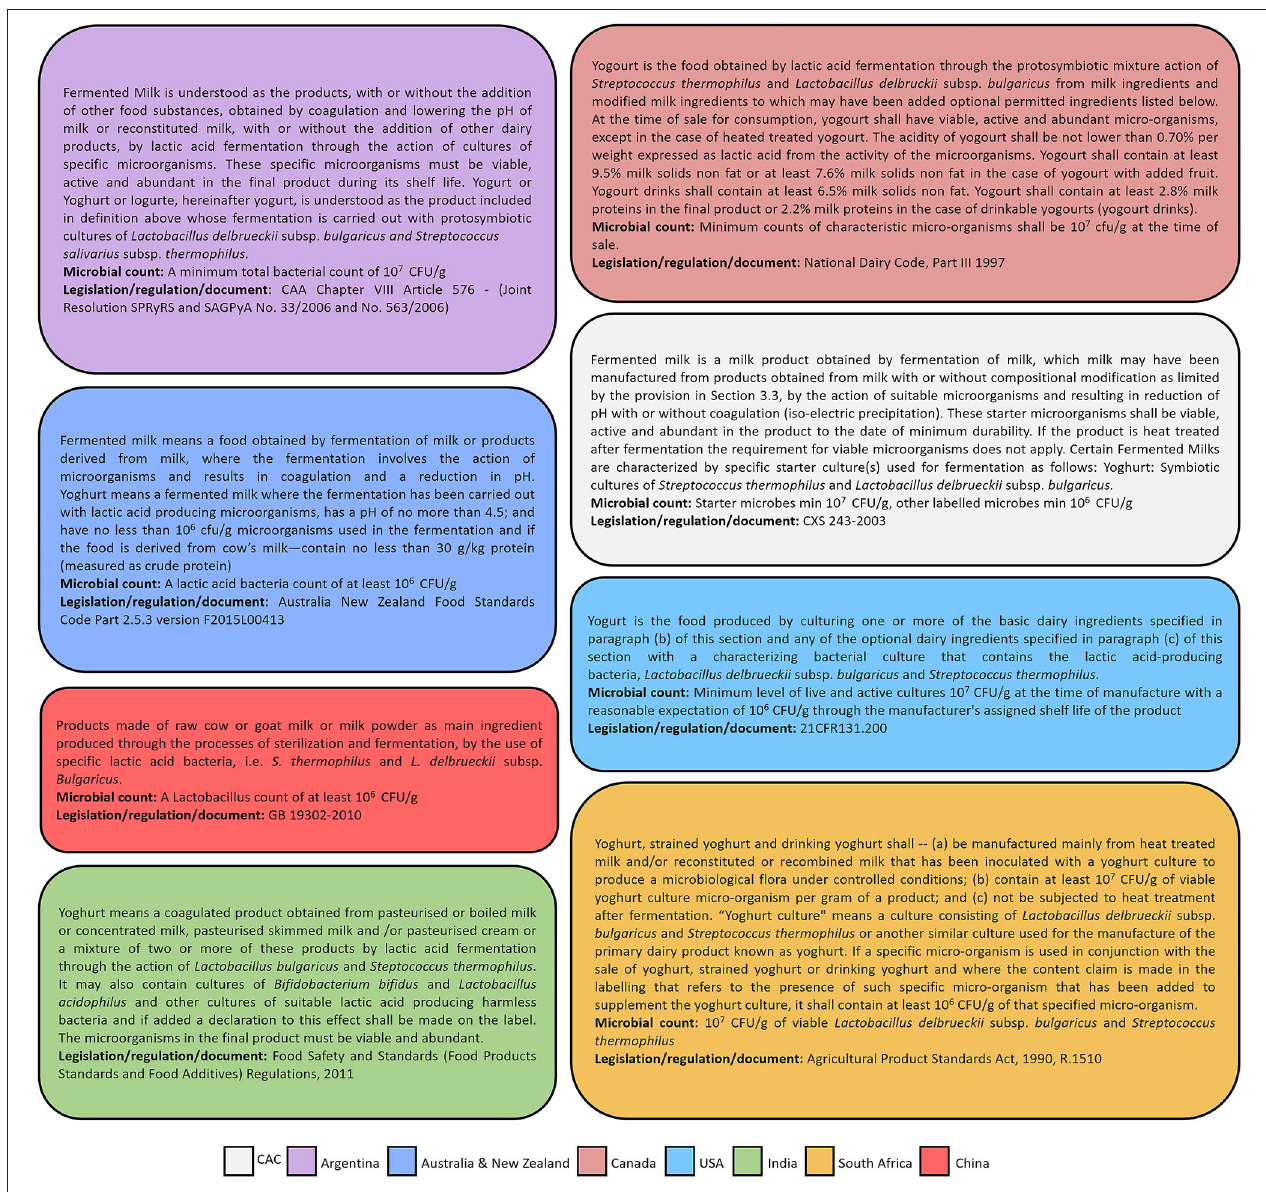
FIGURE 2 | Global definitions of yogurt. Yogurt Standards for select countries and the Codex Alimentarius Commission (CAC) are described. Microbiological details including recommended species composition and microbial amounts are shown. CFU, colony forming